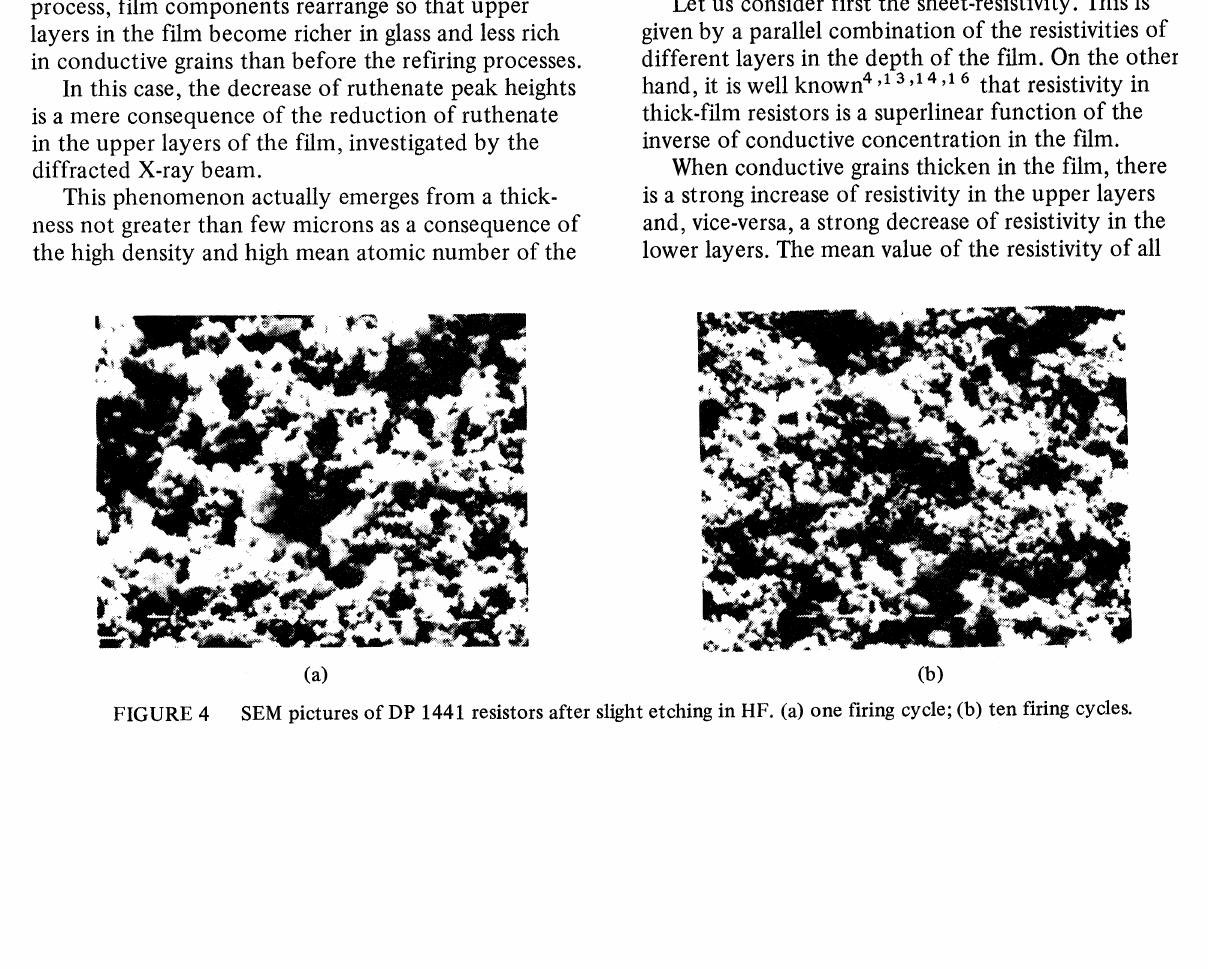
SEM pictures of DP 1441 resistors after slight etching in HF. (a) one firing cycle; (b) ten firing